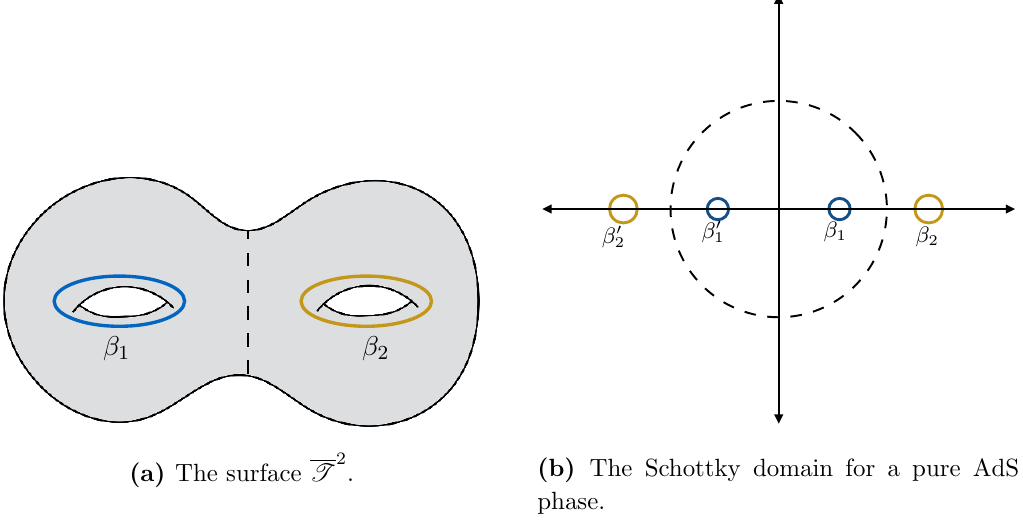
(cid:10) (cid:11) 0 jT 2 j 0 . The